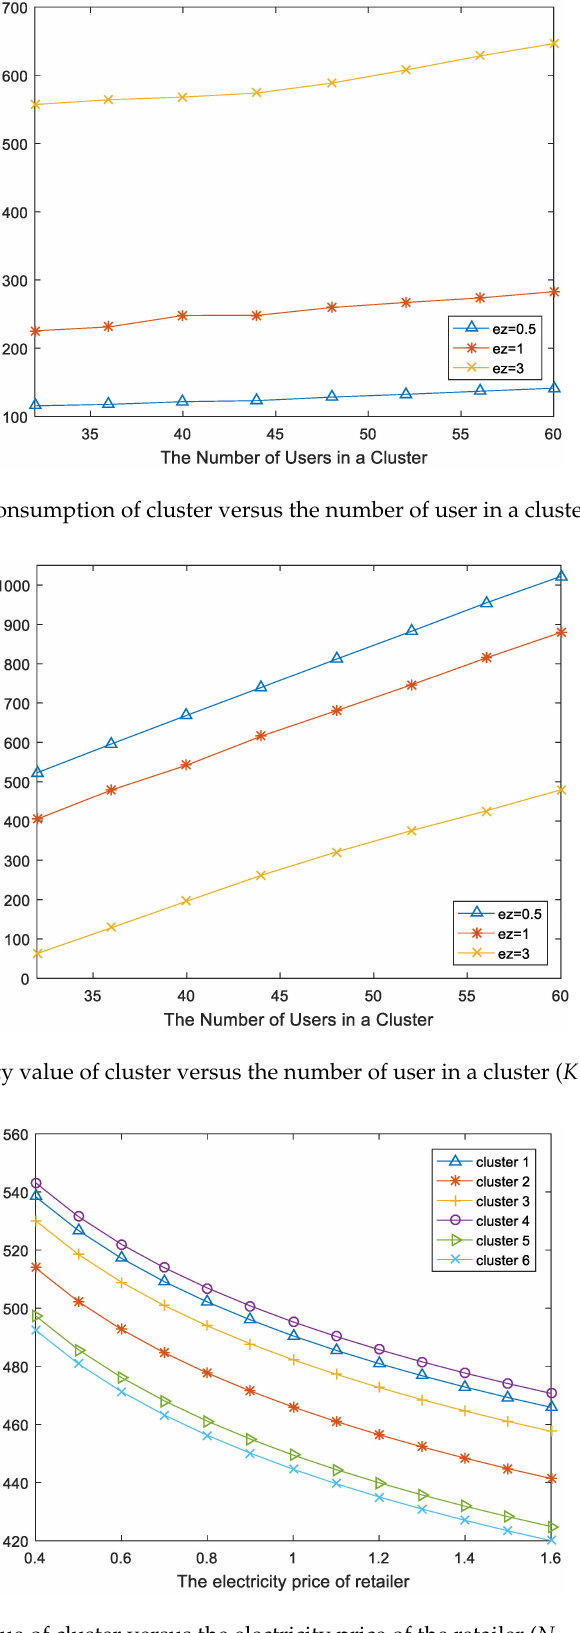
Figure 7. Utility value of cluster versus the electricity price of the retailer ( N = 32, K = 8, J =